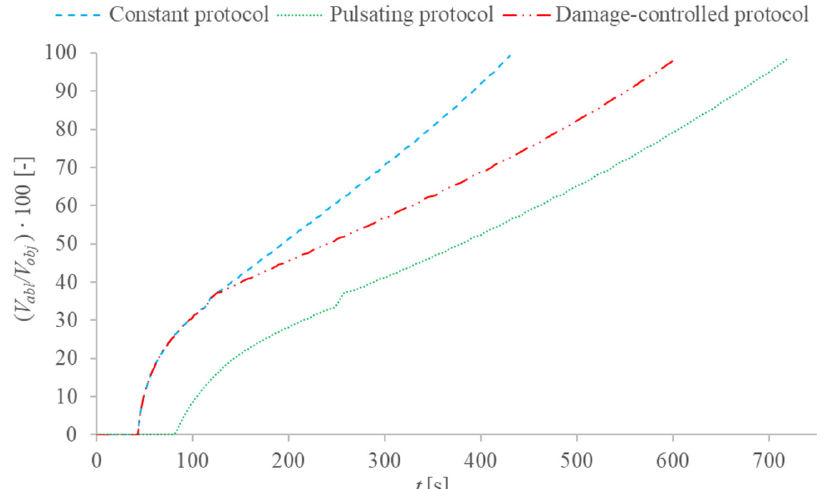
Figure 6. Percentage of ablated volume on the total objective volume during the distinct protocols.